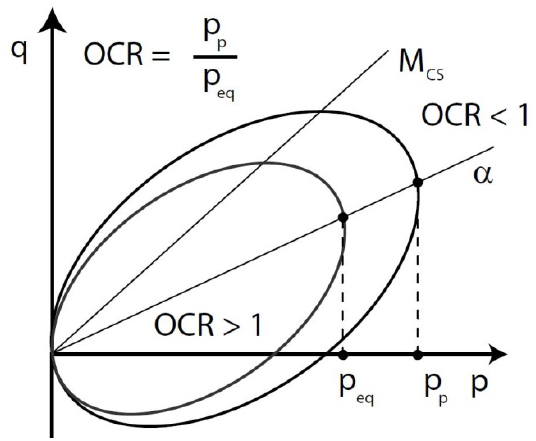
Figure 16: The Leoni model